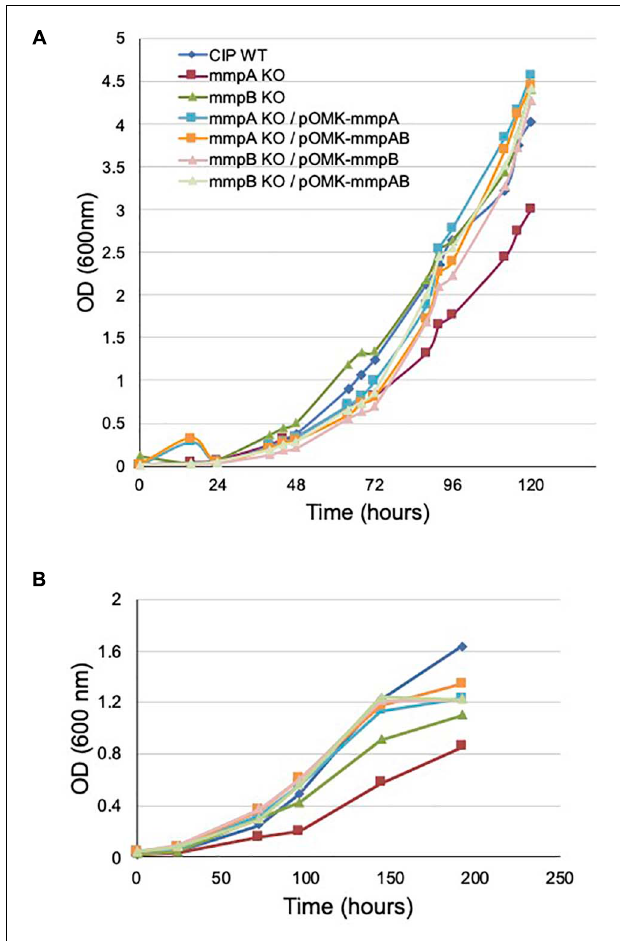
FIGURE 4 | Growth rates of wild-type Mmas , its isogenic mmpA and mmpB knock-out mutants and the complemented porin mutants in GAS-tyloxapol (A) and glucose-based medium (B) at 37 ◦ C. Shown are representative results of two independent experiments. The glucose-based minimal medium consists of 20 mM asparagine, 1.5 mM KH 2 PO 4 , 0.75 mM Na 2 HPO4, 50 µ M FeCl 3 , 1.6 mM MgSO 4 , 4.5 micromolar CaCl 2 , 3.5 µ M ZnSO 4 , 0.59 micromolar MnSO 4 , 10 mM glucose and 0.05% tyloxapol in 50 mM MOPS (pH 7.0).